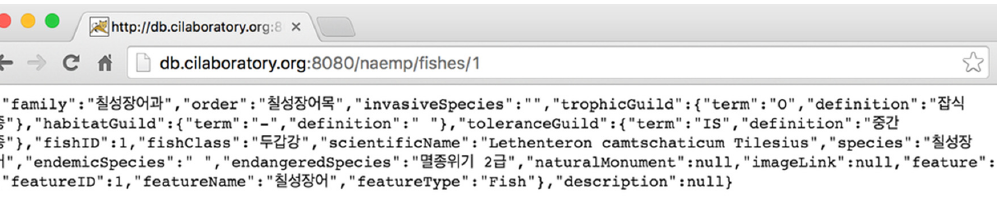
Figure 5. Snapshot of a web browser displaying the representation data for Arctic lamprey.